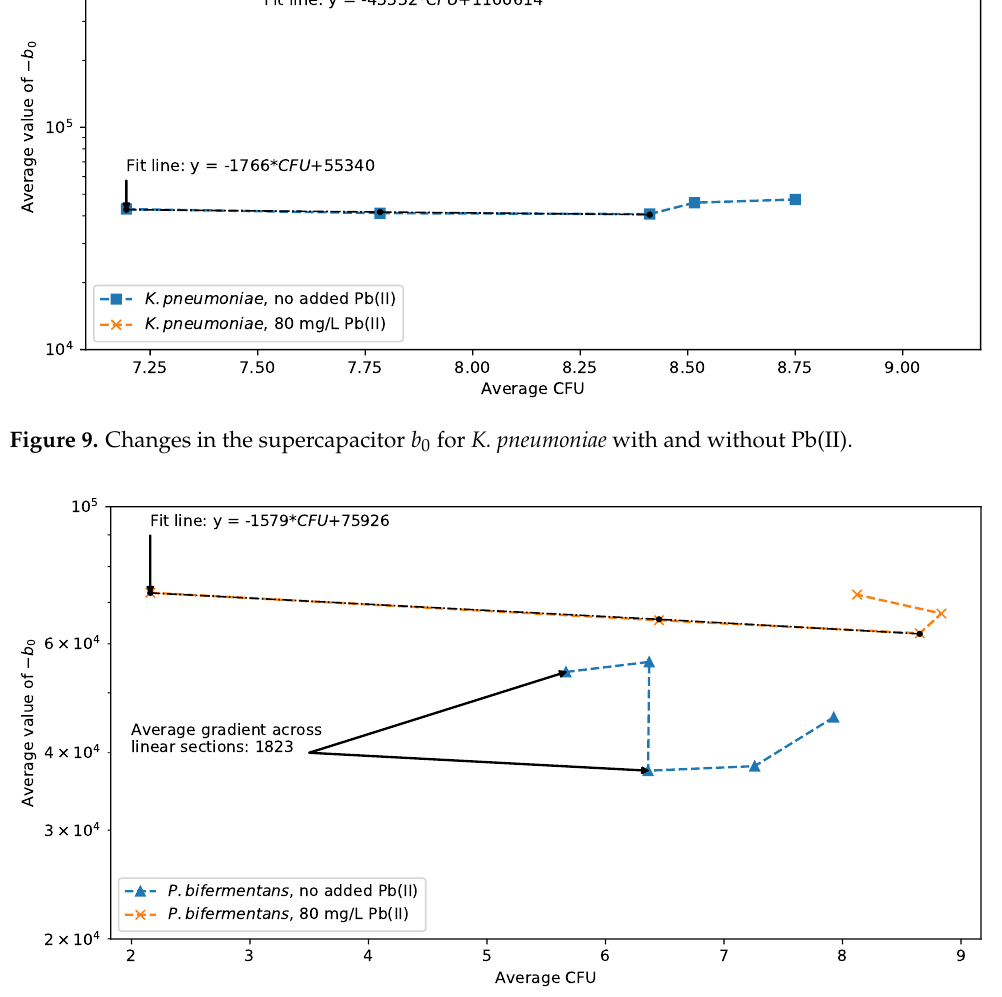
Figure 10. Changes in the supercapacitor b 0 for P. bifermentans with and without Pb(II). The average time progression correlation behavior of the extracted supercapacitor, − b 0 , for P. bifermentans in Figure 10 supports the accordance between the CFU count data of Figure 2b. In the presence of Pb(II), the pronounced inversion on both axes of Figure 10 at the last time point relates to the negative growth rate of P. bifermentans after 10 h. A